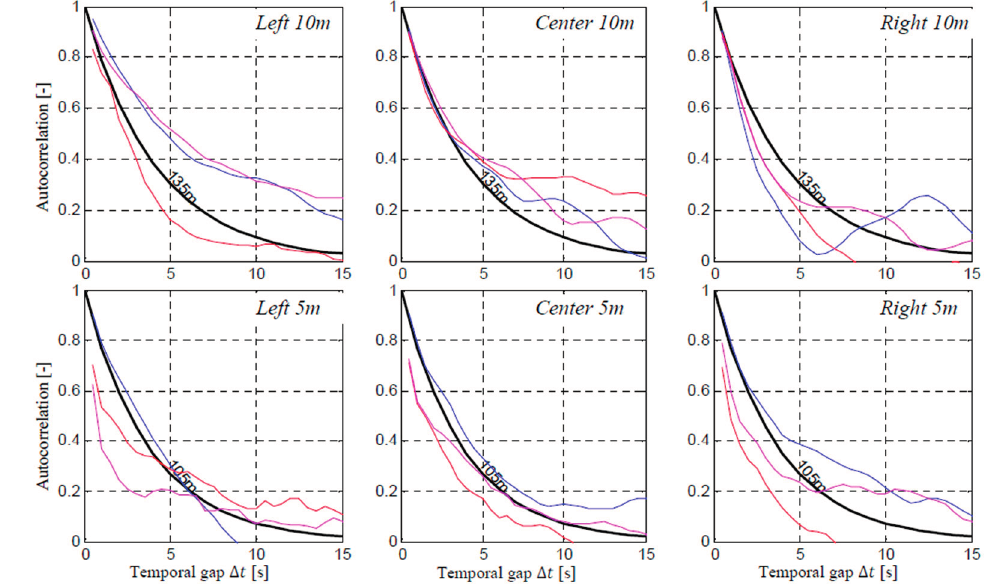
Figure 10. Stream wise correlation analysis. Colored lines: LES results. u (blue), v (red) and w (purple). Black line: